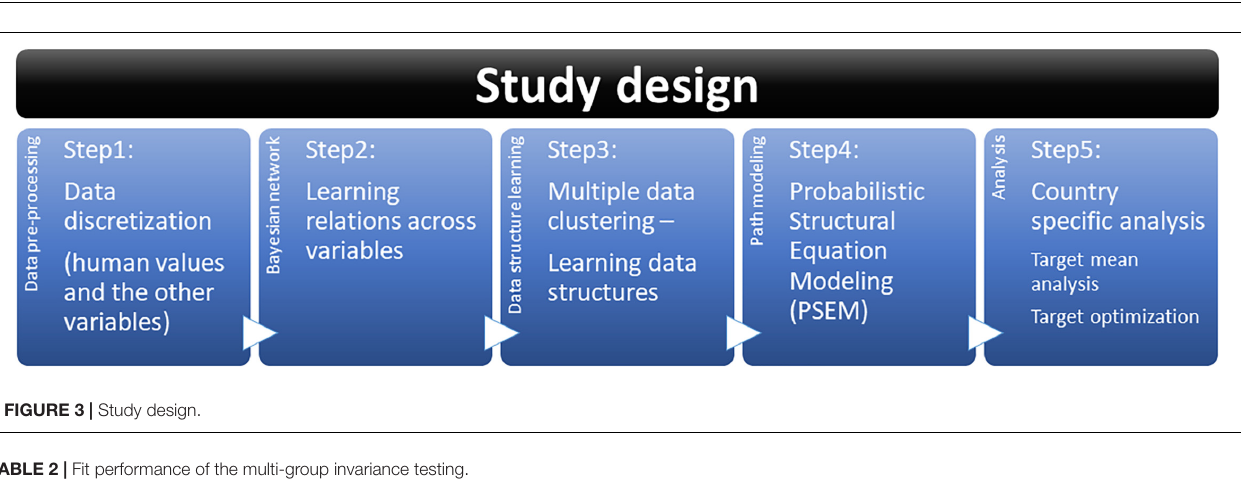
FIGURE 2 | Schwartz theory of ten basic human values (Schwartz, 2012a,b).